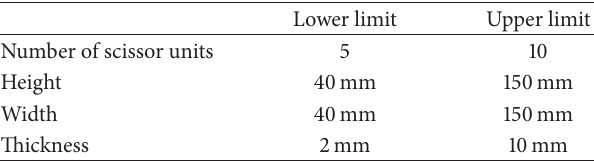
Table 2: Boundary values for the seven design variables (height, width, and thickness of both the polar and the translational